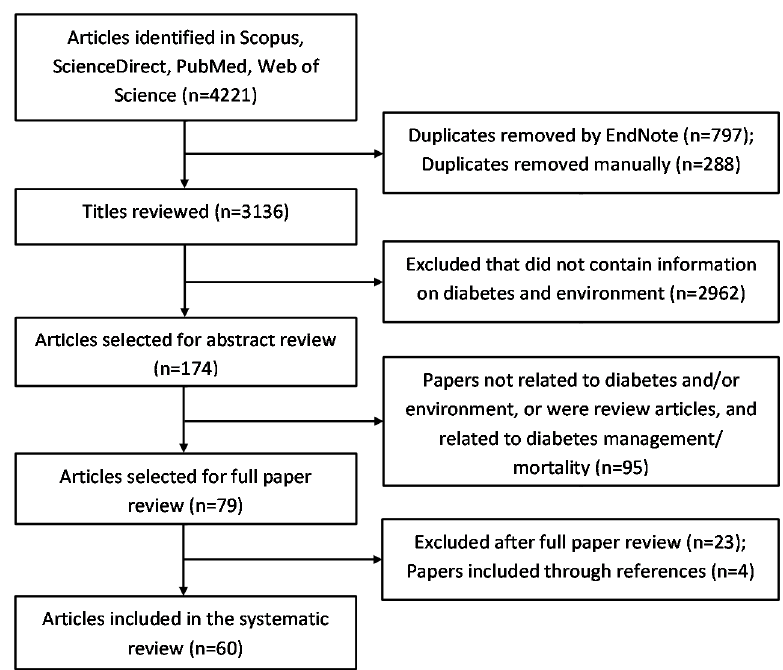
Figure 2. Flow chart illustrating the search and selection process.